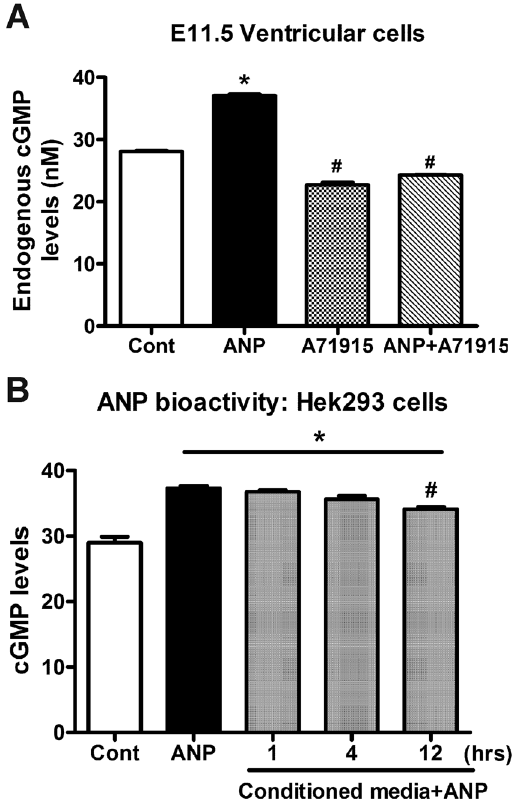
Figure 3. The effects of exogenous ANP and A71915 on cGMP production in E11.5 ventricular cells and assessment of ANP bioactivity. ( A ) Cellular cGMP levels in E11.5 ventricular cells treated with ANP (1 μ g/ml) and or A71915 (1 µ M) were determined using a competitive HTRF immunoassay. The baseline level of cGMP (Cont) was measured to be 28.1 ± 0.2 nM/ 100,000 cells. Addition of exogenous ANP resulted in a significant increase in cGMP. Co-treatment of cells with both ANP and A71915 resulted in lower levels cGMP compared to untreated cells. N = 3 independent experiments, performed in duplicate wells. Each bar represents mean ± SEM. * P < 0.005 Vs. Cont, # P < 0.005 Vs. Cont or ANP (1 μ g/ml), One-way ANOVA with Tukey post hoc test. ( B ) Assessment of ANP bioactivity in the conditioned media of E11.5 ventricular cells: Conditioned media was collected at 1, 4 and 12-hour time points and transferred to HEK293 cells, and cGMP levels were measured. As a negative control (Cont), cGMP production was measured in HEK293 cells that were not treated with ANP. As a positive control, cGMP levels were measured in HEK293 cells treated directly with fresh ANP (1 μ g/ml). Over 12 hours, conditioned media treatment maintained significantly higher levels of cGMP with a minimal decline in bioactivity. N = 4 independent experiments, performed in duplicate wells. Each bar represents mean ± SEM. * P < 0.005 Vs. Cont, # p < 0.05 Vs. ANP or 1 hr, One-way ANOVA with Tukey post hoc